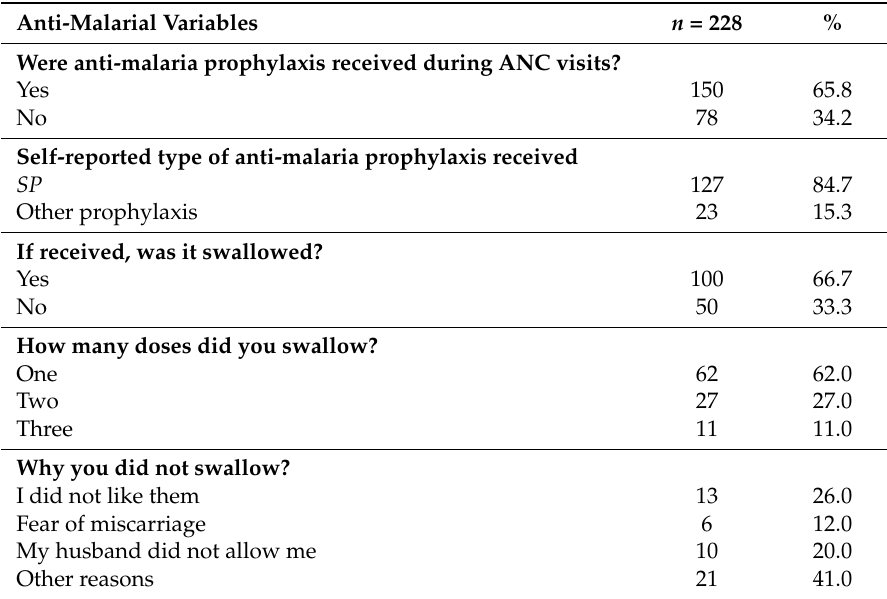
Table 3. Anti-malaria prophylaxis and women compliance data in Simiyu region in